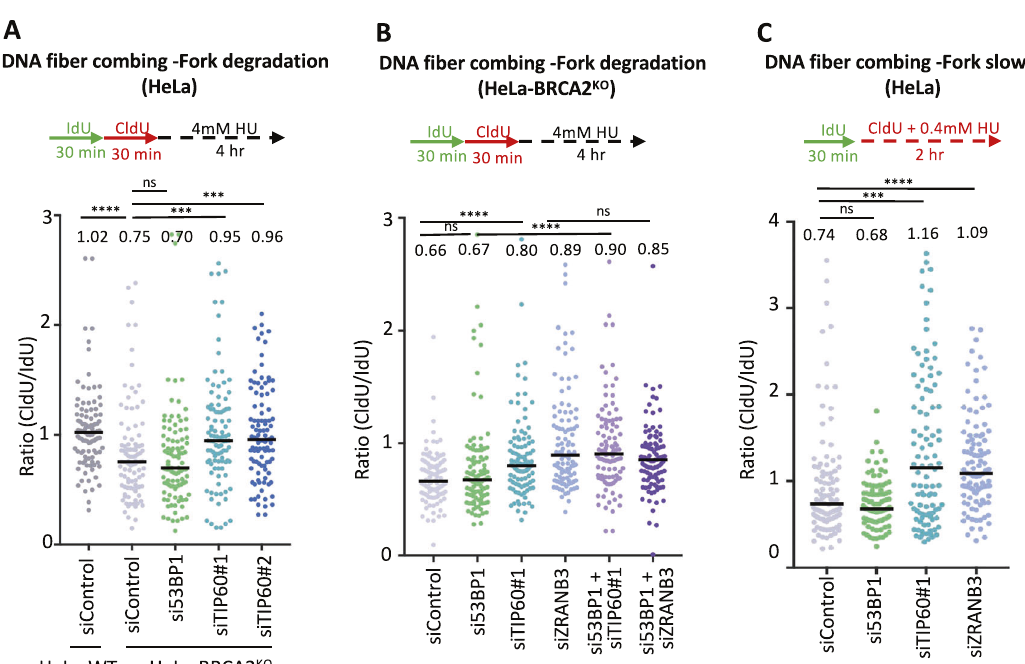
Fig. 1 Loss of TIP60 suppresses stalled fork degradation in BRCA2-knockout cells in a 53BP1-independent manner. A DNA fi ber combing assays showing that TIP60 depletion suppresses HU-induced fork degradation in BRCA2-knockout HeLa cells. The ratio of CldU to IdU tract lengths is presented, with the median values marked on the graph and listed at the top. At least 100 tracts were quanti fi ed for each sample. Asterisks indicate statistical signi fi cance (Mann – Whitney test). A schematic representation of the assay conditions is shown at the top. Western blots con fi rming the knockdown are shown in Supplementary Fig. S1A. B DNA fi ber combing assays showing that 53BP1 is not required for fork protection mediated by TIP60 loss in BRCA2-de fi cient cells. 53BP1 depletion in HeLa-BRCA2 KO does not affect fork degradation, and does not affect the suppression of fork degradation induced by TIP60 knockdown in these cells. Depletion of the translocase ZRANB3 which catalyzes fork reversal is used as a control, since only reversed forks are subjected to degradation. The ratio of CldU to IdU tract lengths is presented, with the median values marked on the graph and listed at the top. At least 100 tracts were quanti fi ed for each sample. Asterisks indicate statistical signi fi cance (Mann – Whitney test). A schematic representation of the assay conditions is shown at the top. Western blots con fi rming the knockdown are shown in Supplementary Fig. S1B. C DNA fi ber combing assay showing that TIP60 depletion in HeLa cells impairs HU-induced fork slowing. Knockdown of ZRANB3, which suppresses fork reversal, is shown as control. The ratio of CldU to IdU tract lengths is presented, with the median values marked on the graph and listed at the top. At least 100 tracts were quanti fi ed for each sample. Asterisks indicate statistical signi fi cance (Mann – Whitney test). A schematic representation of the assay conditions is shown at the